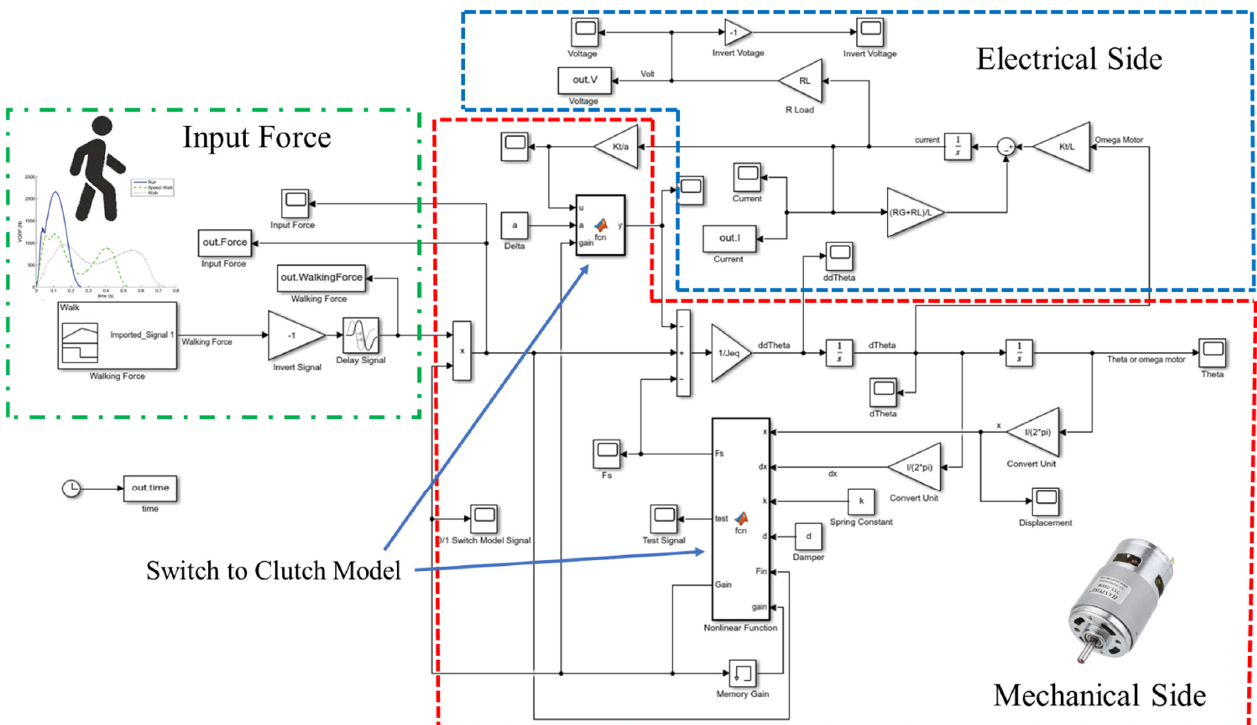
Figure 2. Simulink model for the electromagnetic (EM) generator with lead-screw design and one-way clutch mechanism. Table 1 . Genpath V2 parameters .